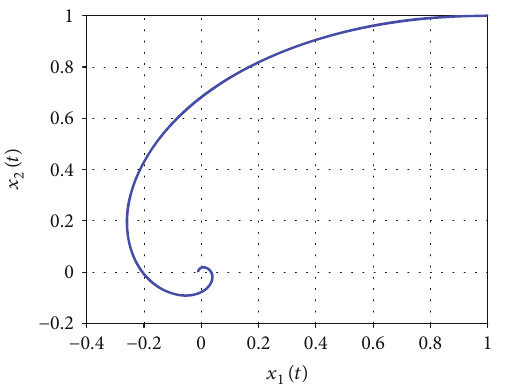
Figure 4: Stability simulation of Example 20 for x